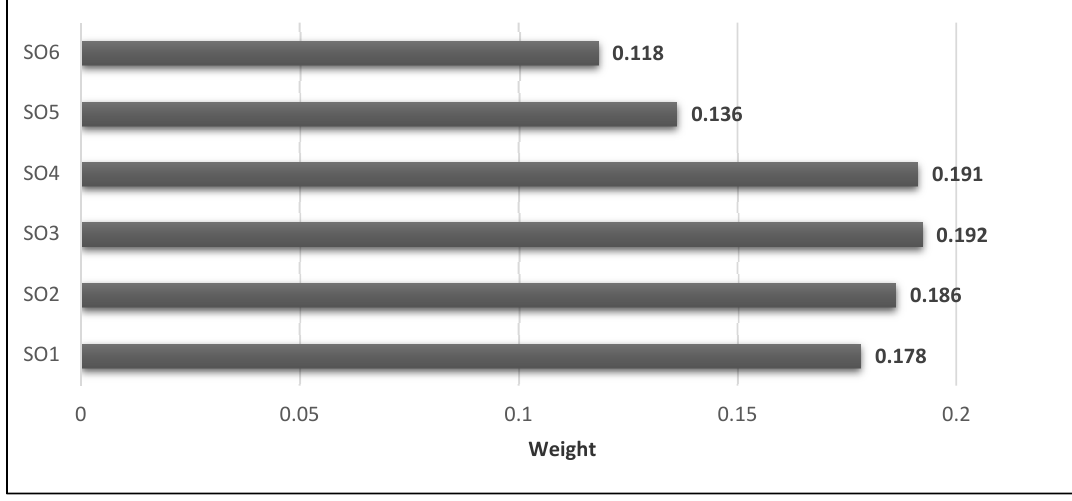
Figure 4. Ranking of green innovation sub-criteria with respect to the social (SO) criteria.